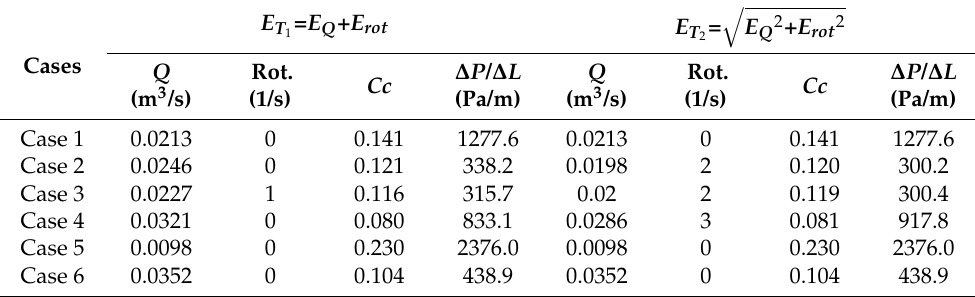
Table 6. Optimal flow rate and pipe rotation speeds when the cut-off cuttings concentration is selected as 12%.